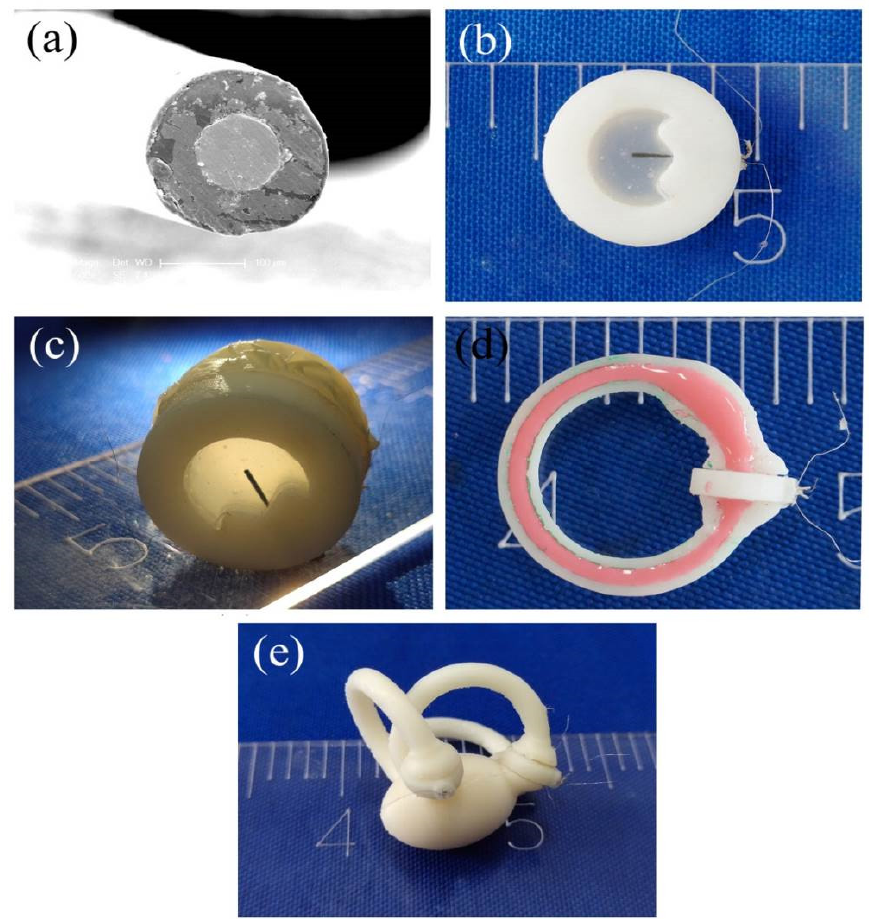
Figure 2. ( a ) An SEM (scanning electron microscope) image of the cross-section of the SMPF, ( b ) a photograph of a BA, ( c ) a photograph of the straight semicircular canal, ( d ) a photograph of the section of the 1-BSC, and ( e ) a photograph of the 3-BSC.